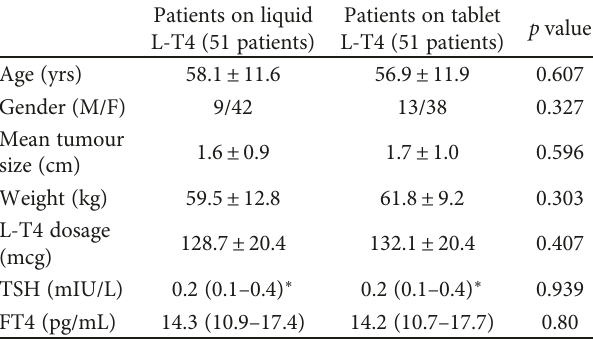
Table 1: Baseline demographics and clinical characteristics of the patients at the fi rst check-up.